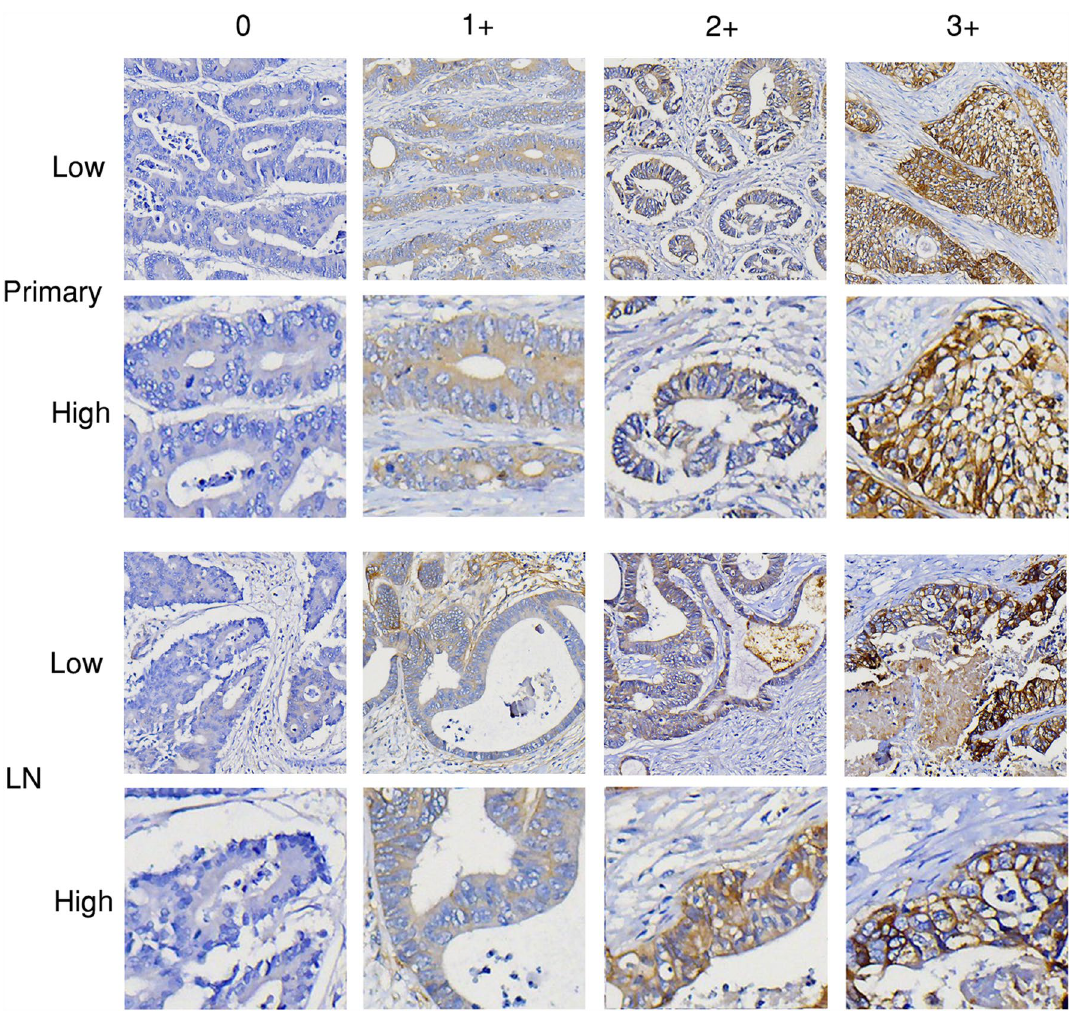
Figure 1. Representative images (EGFR immunohistochemistry staining). Representative images of immunohistochemistry staining scores (0, 1+, 2+, and 3+) for EGFR in primary tumor (Primary) and lymph node metastasis (LN) of CRC. Low: low magnificent power field (× 40); High: high magnificent power field (×